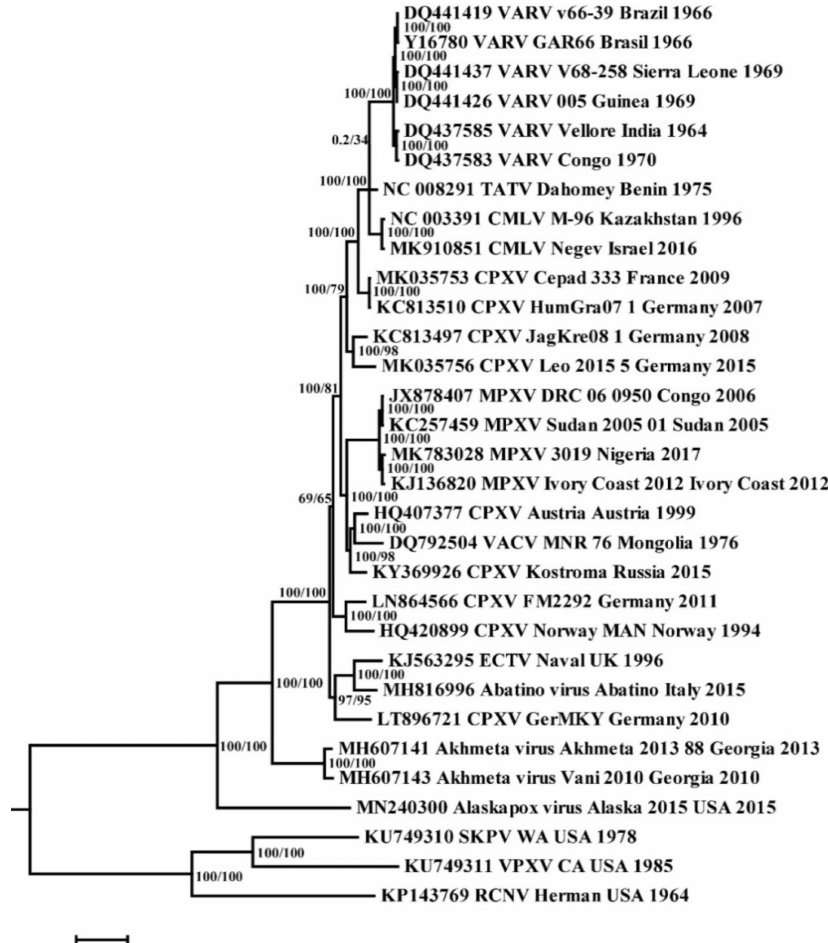
Figure 1. Phylogenetic tree for the highly conserved central genome region of the orthopoxviruses was generated using the maximum-likelihood method. Numbers above branches are SH-aLRT support (%)/bootstrap support (%). Divergence (substitutions per site) scales are given at the bottom. The strains are designated as in Table